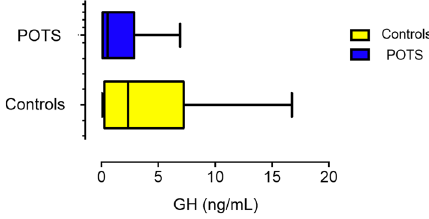
Figure 1. Levels of growth hormone in POTS versus healthy controls. GH, growth hormone; POTS, postural orthostatic tachycardia